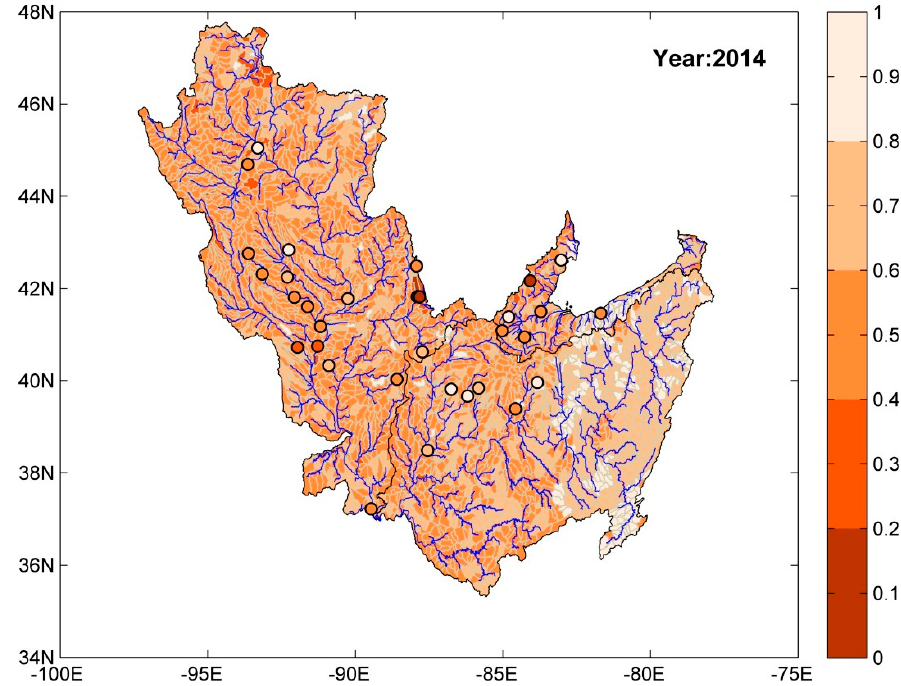
Figure 10. Prediction of watershed health (with respect to orthophosphate) at ungauged HUC-10 basins for the year 2014 using the ensemble model. Circular markers denote the location of USGS- NAWQA stations where orthophosphate measurements were available and are color-coded based on watershed health for the year